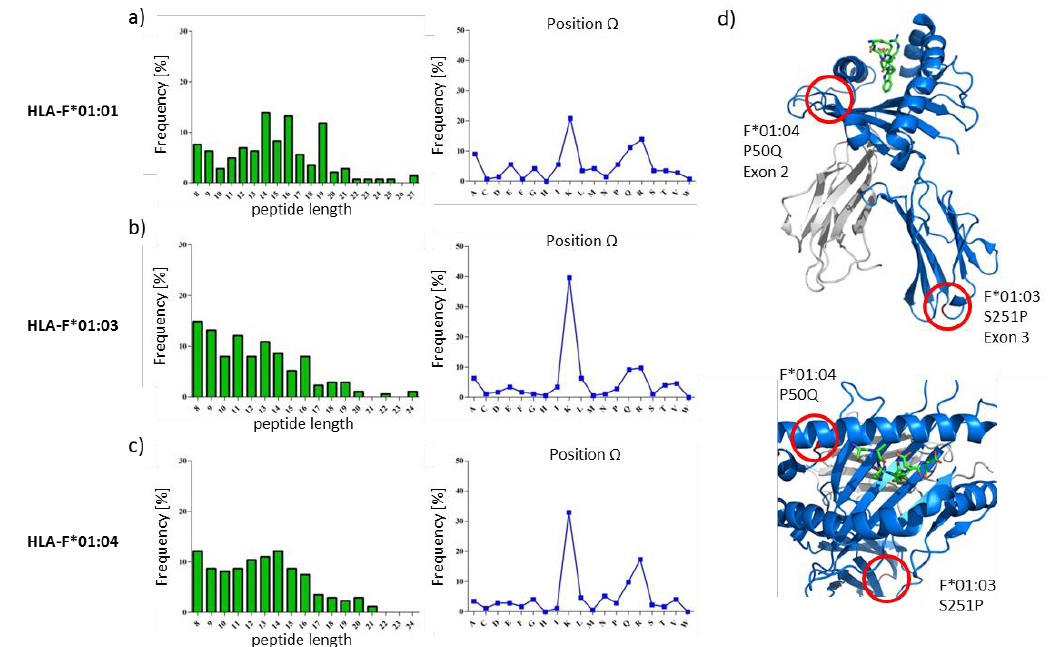
Figure 1. Features of HLA-F restricted peptides. ( a – c ) Length distribution and frequency of amino acid (AA) at position Ω of peptides presented by ( a ) HLA-F*01:01, ( b ) HLA-F*01:03 and ( c ) HLA-F*01:04. Peptide length is given on the x -axis, percentage of observed peptides on the y -axis. The respective AA is given on the x -axis, percentage of observed AA on the y -axis. ( d ) Structure of HLA-F*01:01 (5KNM) from Dulberger et al. [3]. Positions of AA exchanges between three allelic variants are circled in red. P50Q discriminates HLA-F*01:01 from F*01:04; S251P discriminates F*01:01 from 01:03.